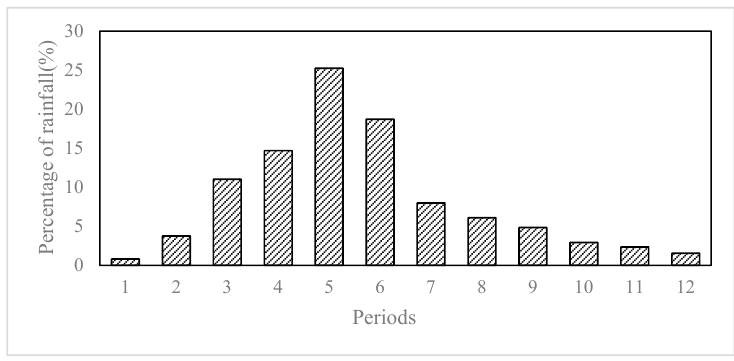
Figure 4. Rainfall distribution of the design hyetograph for scenario 1: single-peak rainstorms.